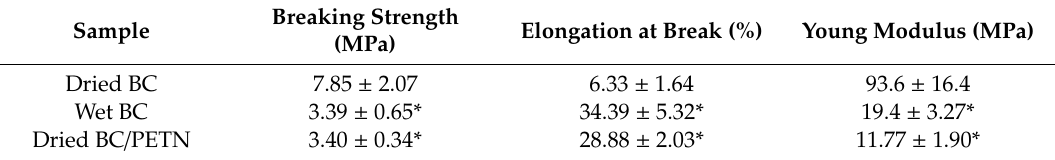
Table 1. The mechanical properties of the BC and BC / PETN membranes.